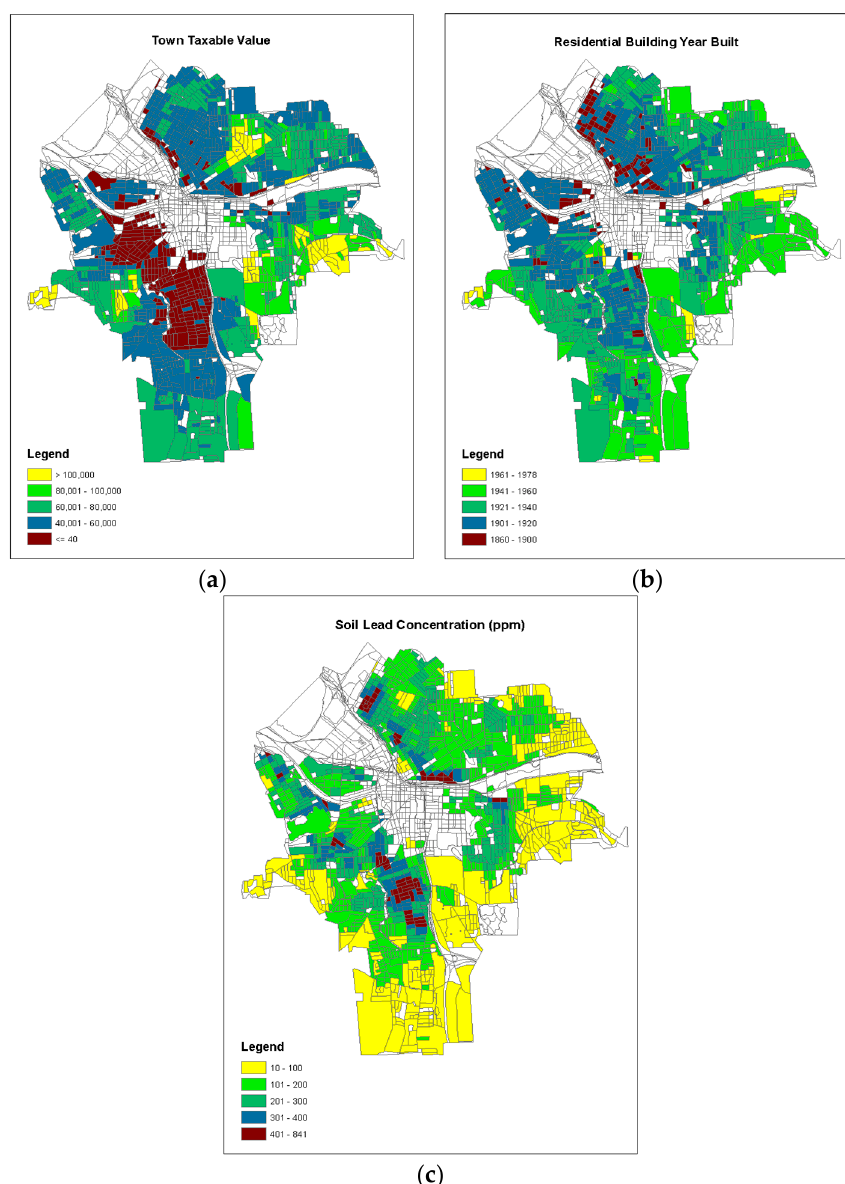
Figure 3. Geographical map of ( a ) the building year of residence; ( b ) the town taxable value of residence; and ( c ) the soil lead concentration in the city of Syracuse, NY, USA, (the blanks are non-residential areas).